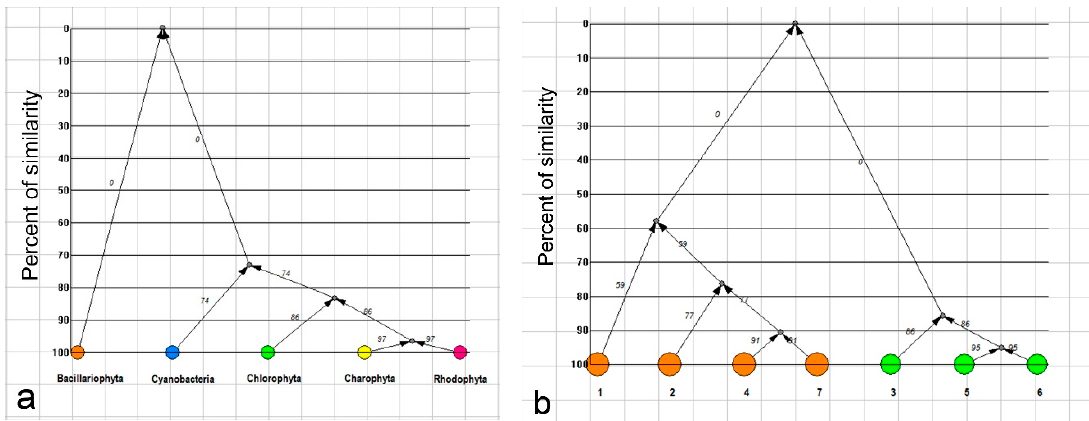
Figure 12. Comparative floristic trees for algal communities in seven studied sites of the Abraham Lincoln Birthplace National Historical Park: taxonomic richness in algal divisions ( a ), and community species richness ( b ). The abbreviations for the sites are the same as in Tables 1 and 2.